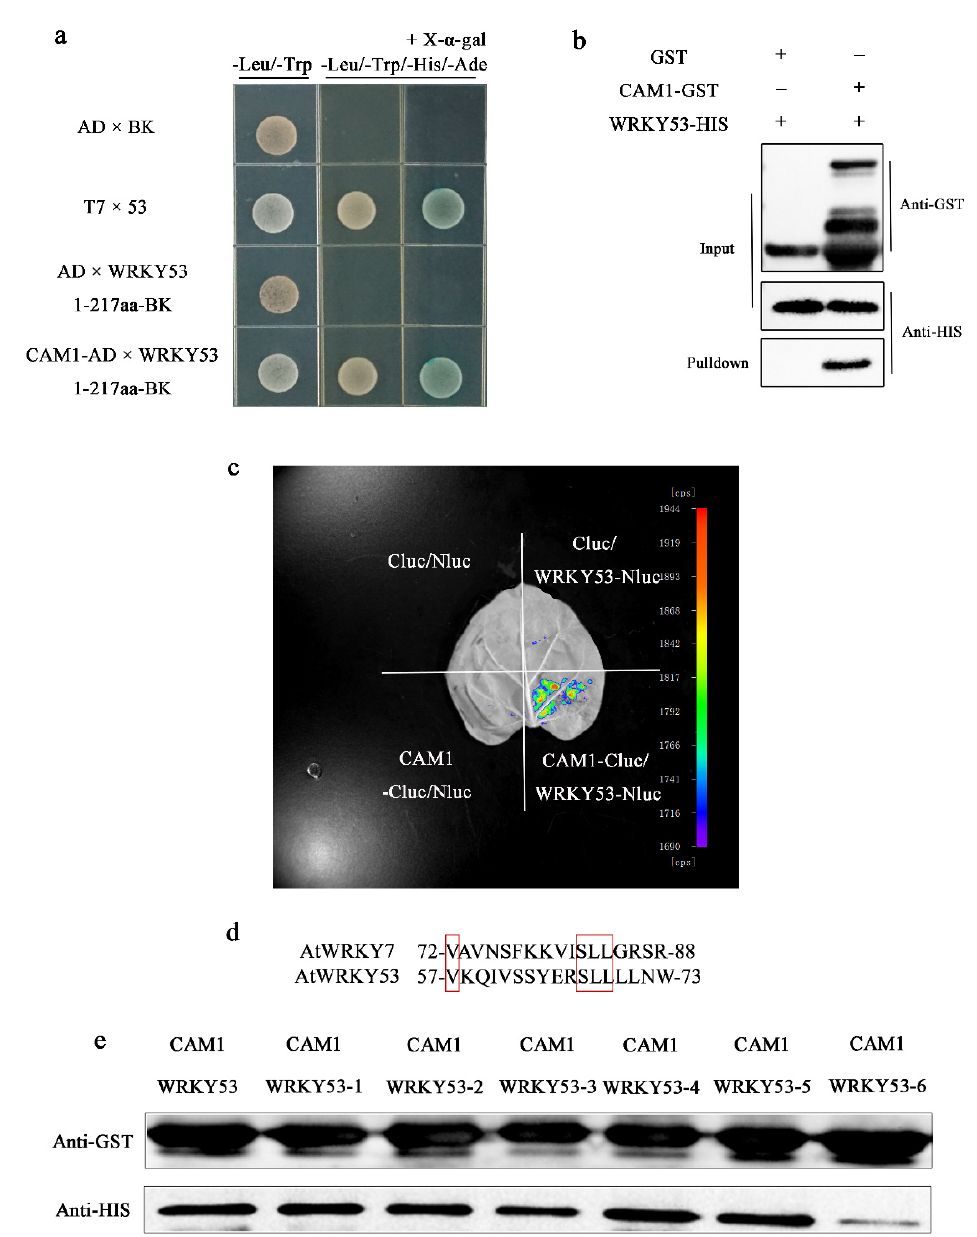
Figure 2. CAM1 interacts with WRKY53. ( a – c ) Y2H, in vitro pull-down and LCI assays, respectively, show that CAM1 interacts with WRKY53. In the Y2H assays, the N terminus of WRKY53 (residues 1–217) was used as the bait vector. ( d ) Conserved amino acids in WRKY53 compared to WRKY7. ( e ) WRKY53 is the unmutated protein; in WRKY53-1, 57 V was mutated to R; in WRKY53-2, 67 S was mutated to R; in WRKY53-3, 58 L was mutated to R; in WRKY53-4, 59 L was mutated to R; in WRKY53-5, 67-69 SLL was mutated to RRR; and in WRKY53-6, four amino acids were mutated to RRRR.